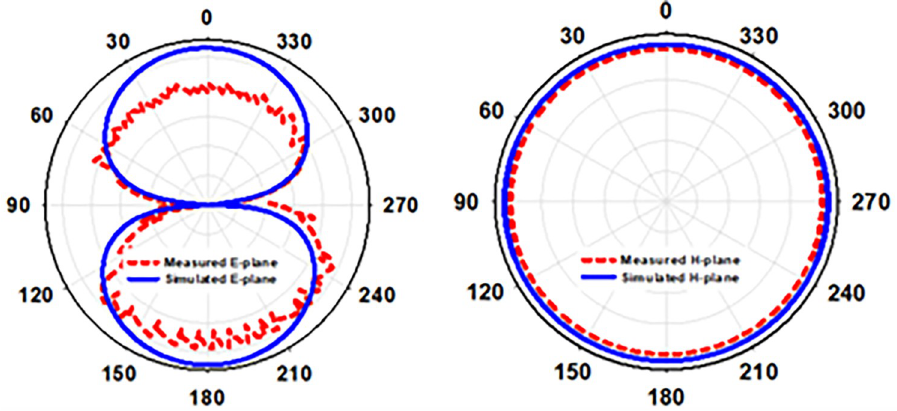
Fig 11. Radiation pattern of an antenna in free space when it is bent in two dimensions along the x-axis (Bx =